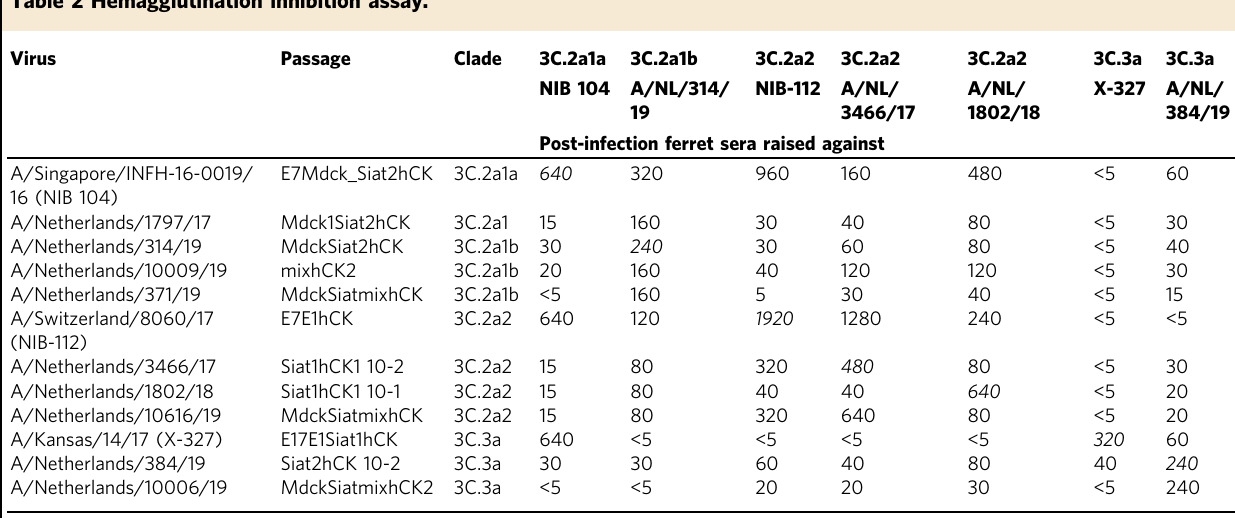
Table 2 Hemagglutination inhibition assay.